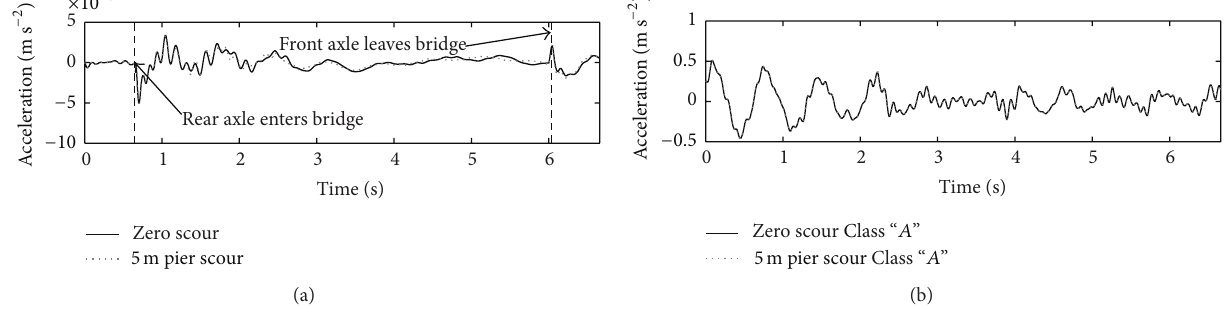
Figure 12: Effect of road roughness on vehicle body accelerations. (a) Vertical body acceleration over smooth road surface for zero and 5 m scour, (b) vertical body acceleration over Class “ 𝐴 ” road surface for zero and 5 m